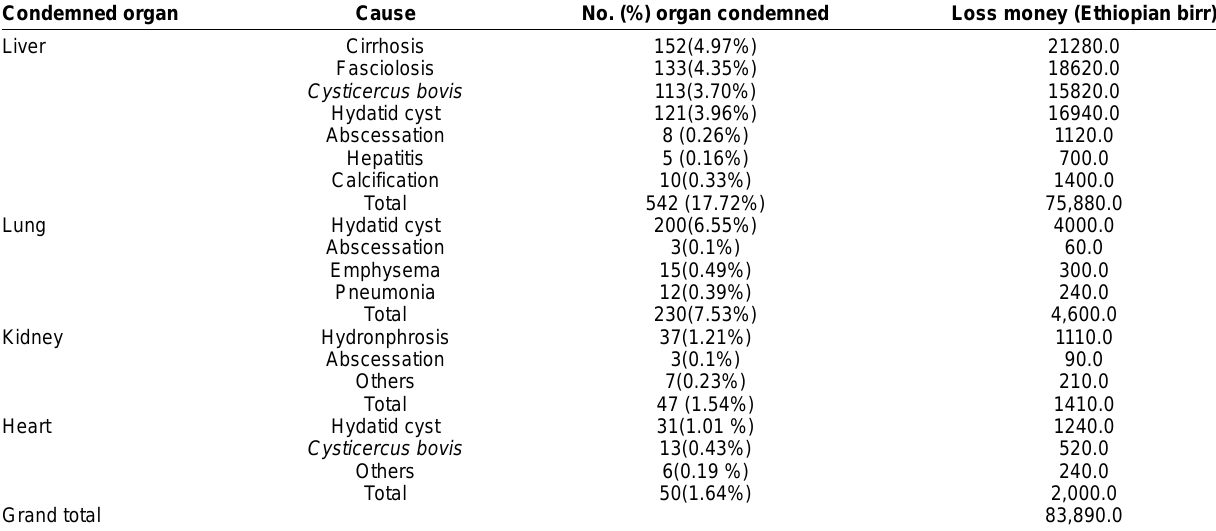
Table-3. Retrospective data on causes, percentage of organ condemnation and economic loss at Adigrat abattoir (September 2010- September 2012). Condemned